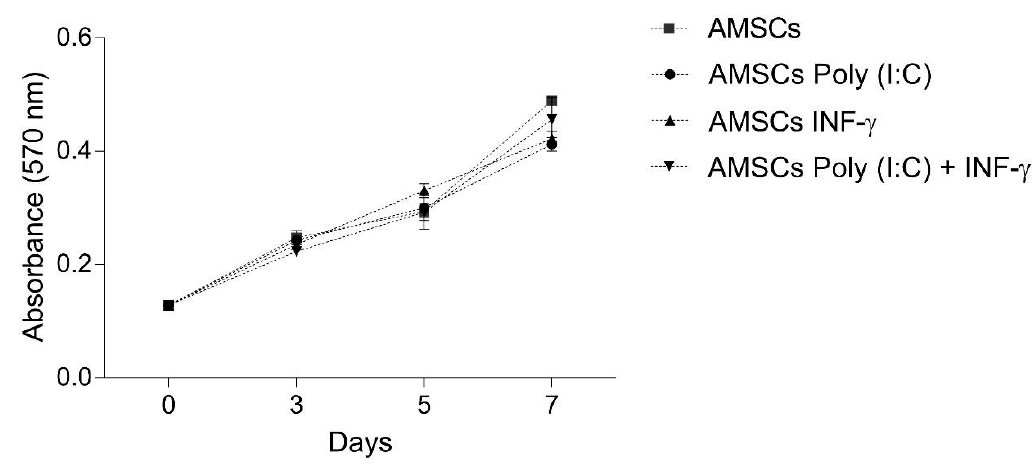
Figure 1. Proliferative capacity of licensed and unlicensed AMSCs. Control AMSCs, AMSCs licensed with 1 µ g/mL of Poly (I:C), AMSCs licensed with 50 ng/mL of INF- γ ; and AMSCs licensed with 50 ng/mL of INF- γ and 1 µ g/mL of Poly (I:C) were cultured and cell proliferation was assessed by MTT in the days 3, 5 and 7 of the culture. No difference of proliferation/viability was observed among the groups. Values represent the means ± SEM. Three independent experiments were performed.